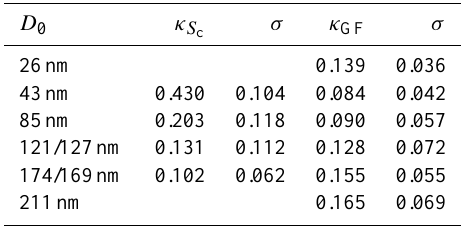
Table 3. κ values for both HTDMA and CCN data, split by an organic:sulphate ratio of ≥ 4:1. D 0 is particle dry diameter and σ is the standard